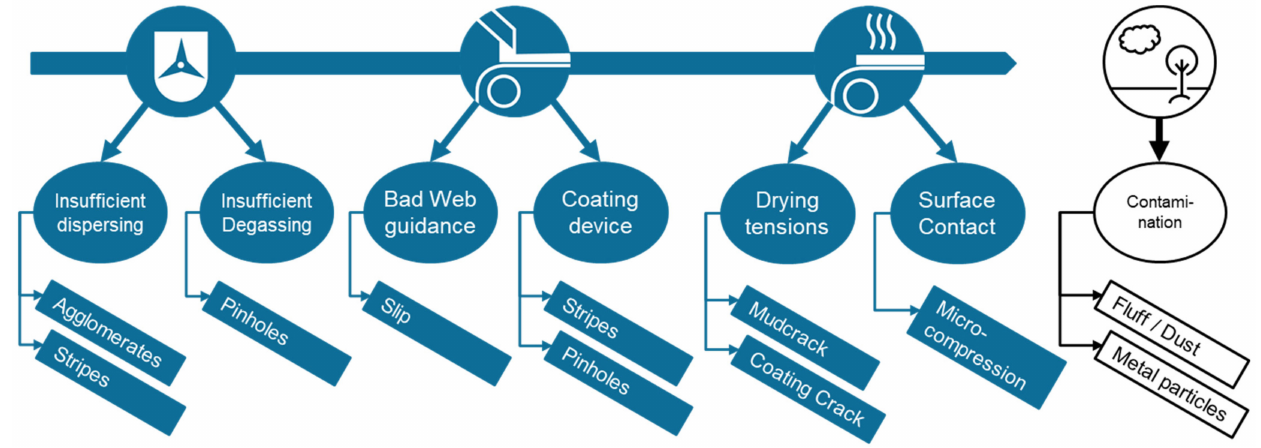
Figure 4. Typical defect types caused by different process steps and environmental conditions.